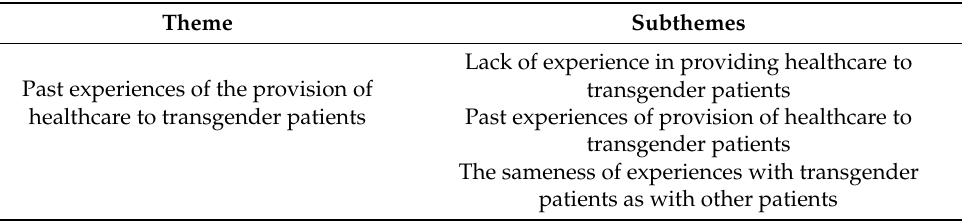
Table 1. Experiences with the provision of healthcare to transgender